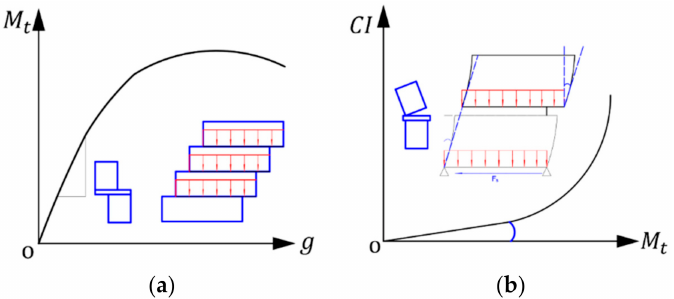
Figure 7. Parameters setting of finite element model: ( a ) Relative dislocation between units; ( b ) Rela- tive rotation between